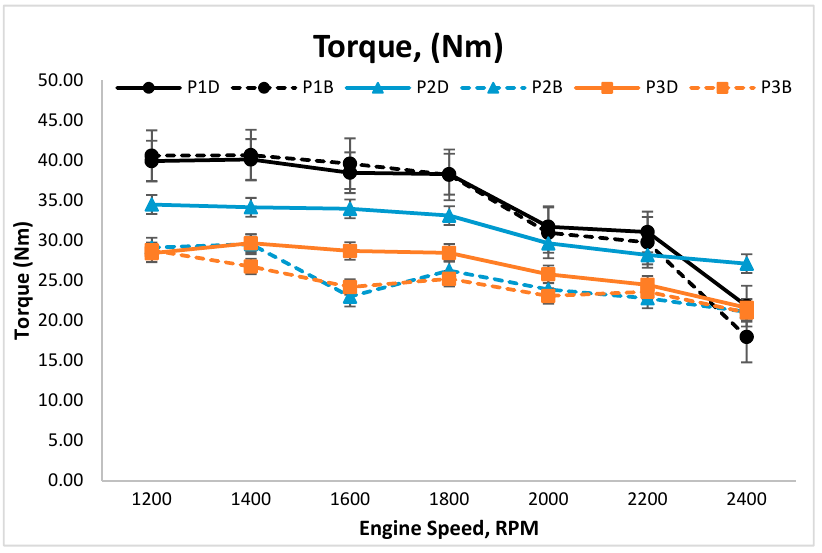
Figure 14. Torque (Nm) produced at variable speeds.